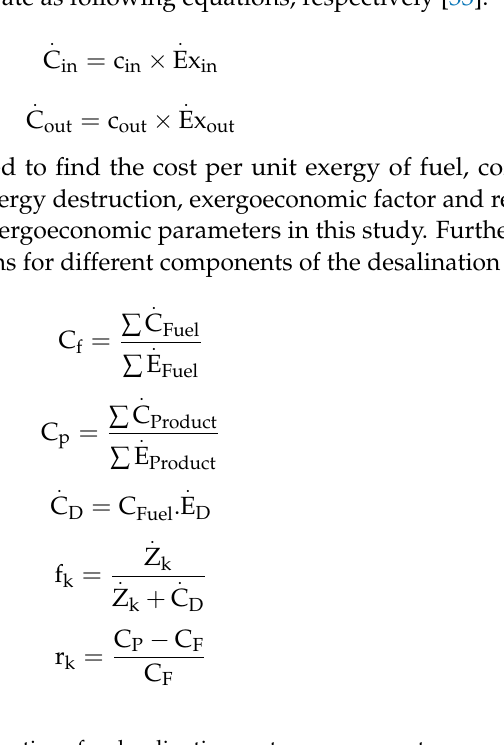
Table 5. Exergoeconomic balance equations for desalination system components. Component Exergoeconomic